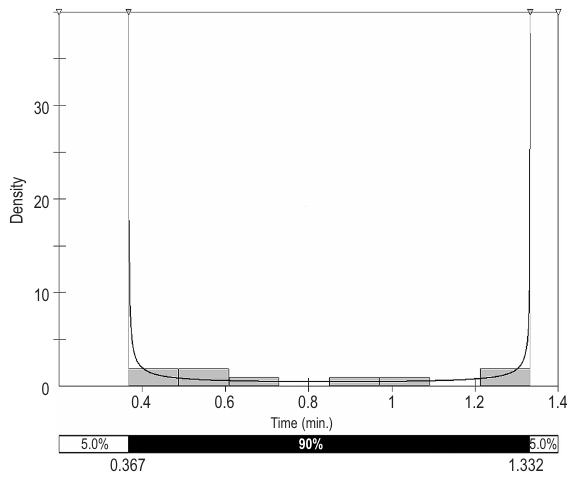
Fig. 9. Statistic distribution of the measured duration data for the activity of “ Preparing ” in the installing process after removing outlier